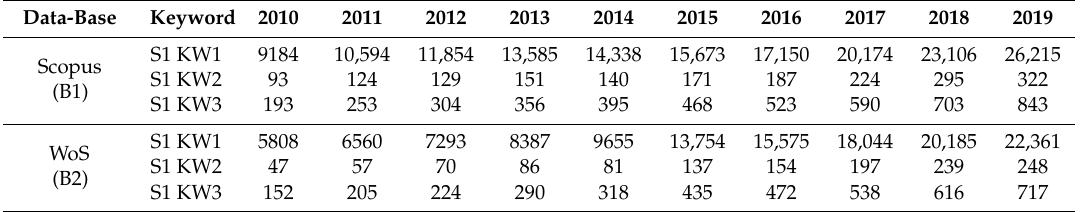
Table 2. Number of published scientific papers in the period from 2010 to